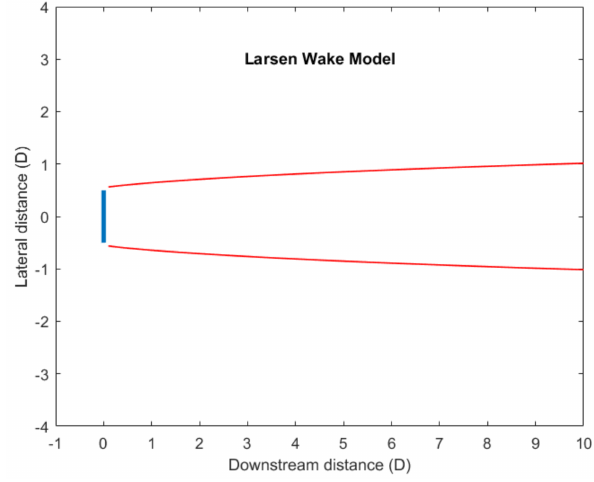
Figure 10. Larsen wake model implemented in MATLAB.